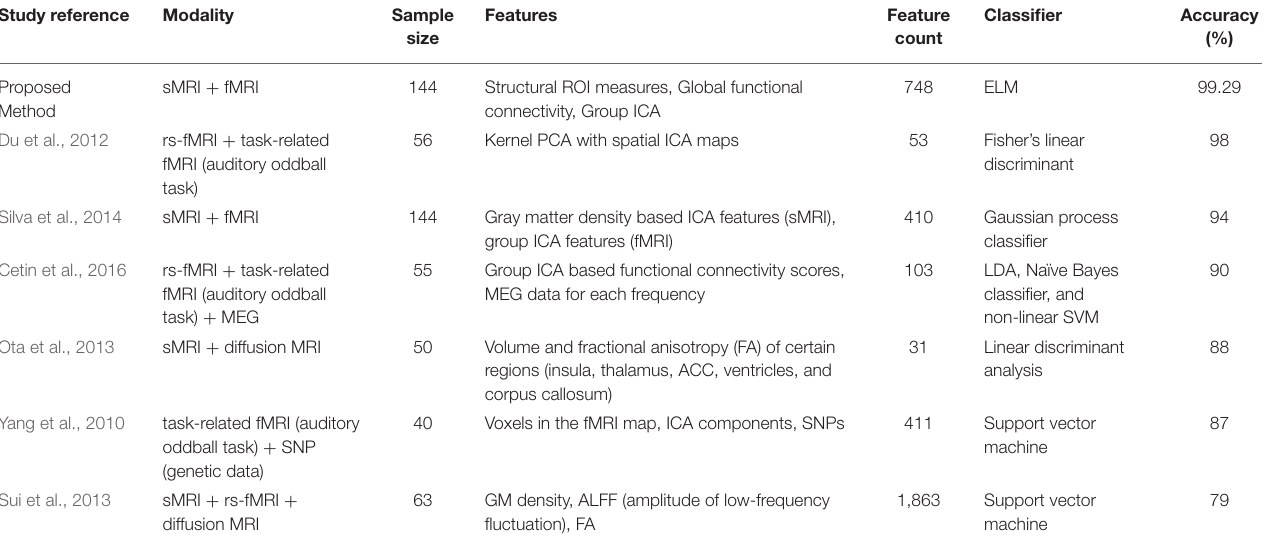
TABLE 6 | Comparison with the classification scores of previous studies using multimodal